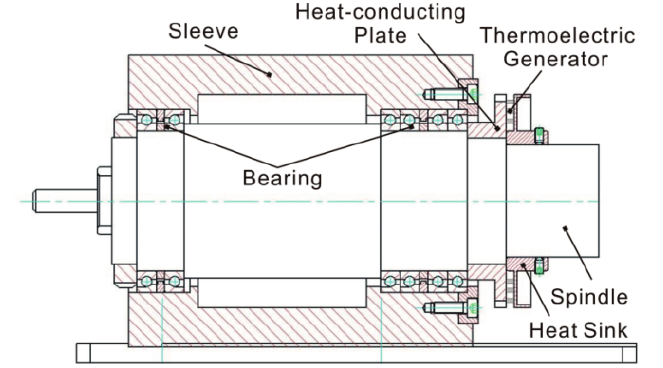
Figure 1. Structure of thermoelectric generator on bearing.